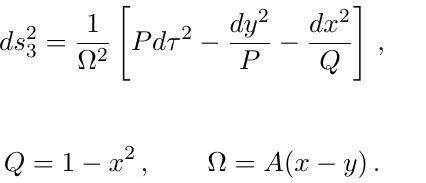
JHEP05(2022)063